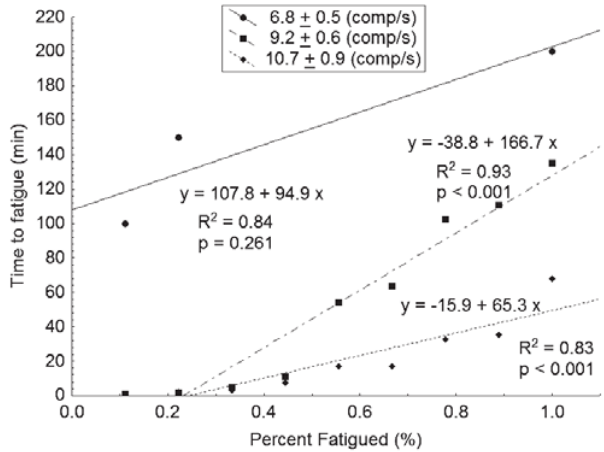
Fig. 8. Scatterplot of the relationship between time to fatigue (min) and percent fatigued for piaus of three different speed classes (lines represent fit of the models for each size